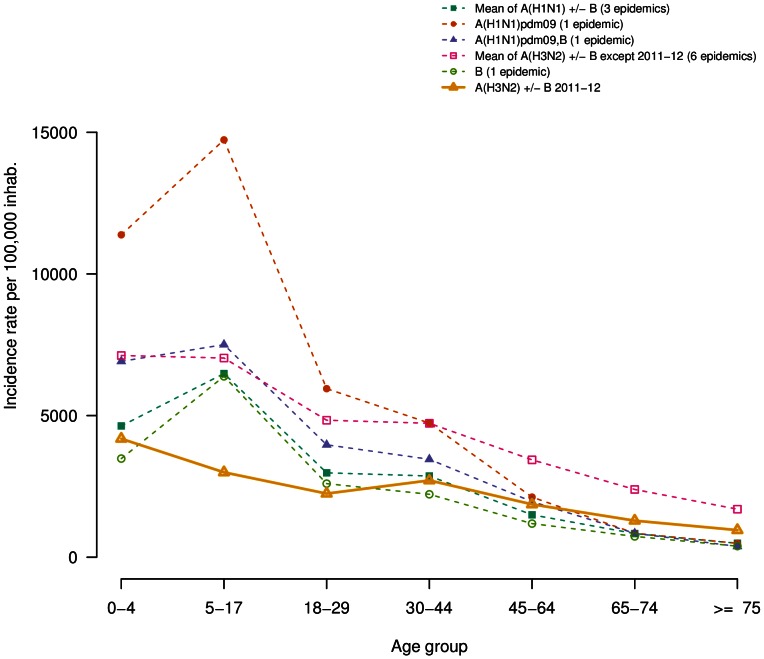
Age specific cumulated incidence rates for the 2011/2012 epidemic (solid line) by viral dominant or co-dominant subtypes for others epidemics from 1999–2000 epidemic (dashed lines).A(H1N1) and co-dominant A(H1N1),B before 2009 pandemic are grouped together). The number of epidemic included in each group is indicated between parentheses in the legend.